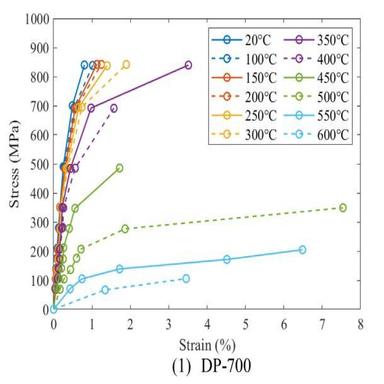
Stress-strain curves obtained from transient-state tests.